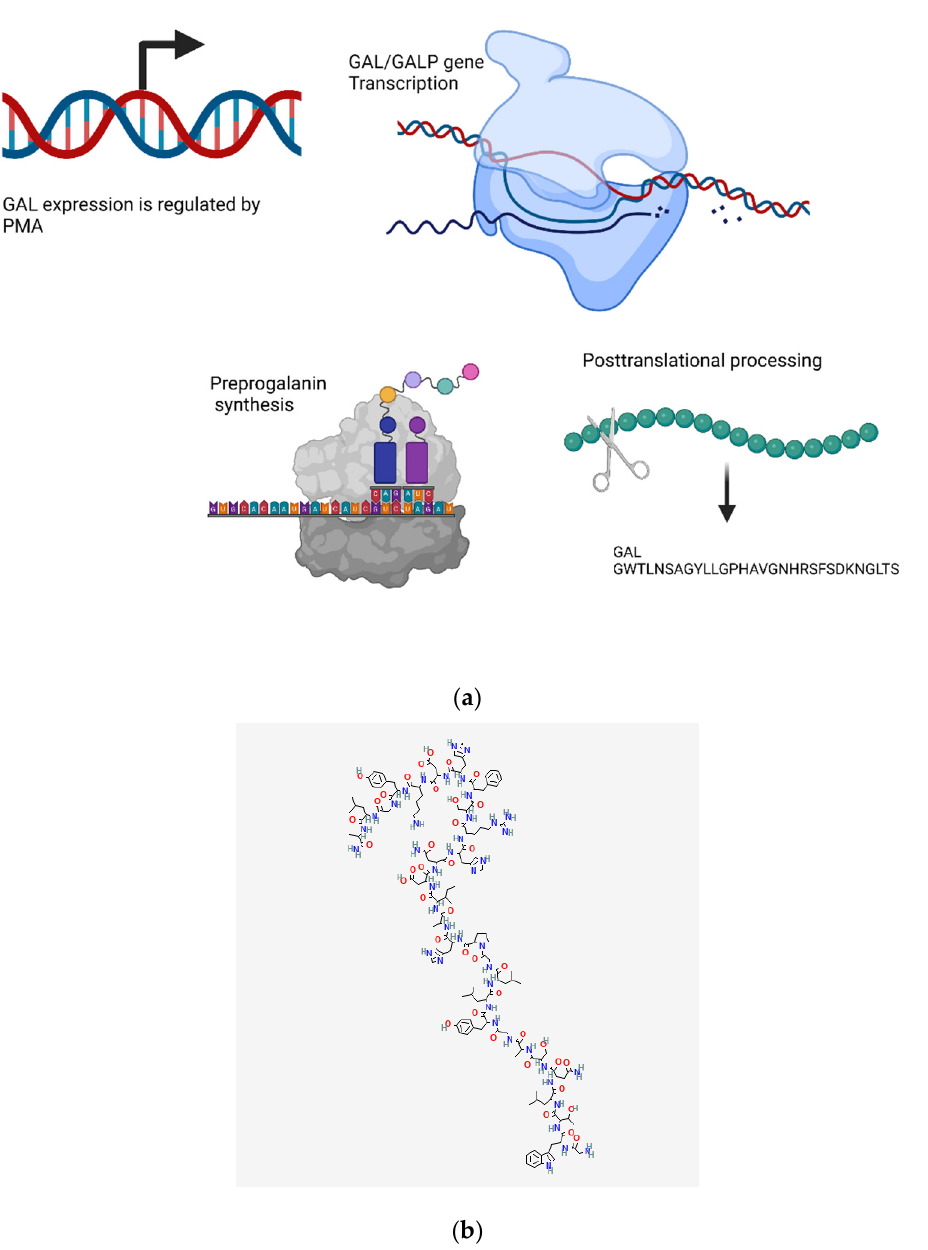
Figure 10. Neuropeptide GAL: ( a ) transcription and synthesis of GAL (created with BioRender.com accessed on 4 November 2021); ( b ) 2D structure image of GAL (swine) (https://pubchem.ncbi.nlm.nih.gov/compound/16174786#section=2D-Structure, accessed on 22 October 2021).